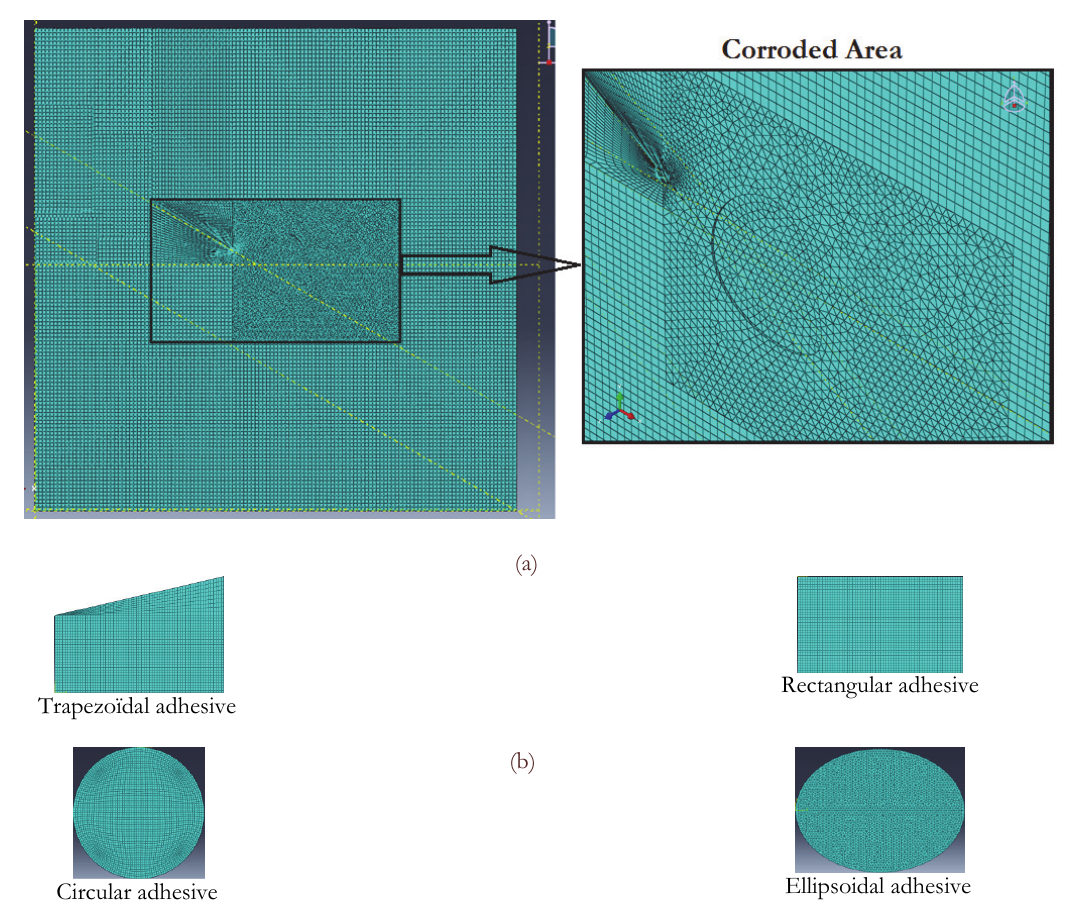
Figure 2: (a) Mesh of the corroded plate, (b) Mesh for different shapes of glue.